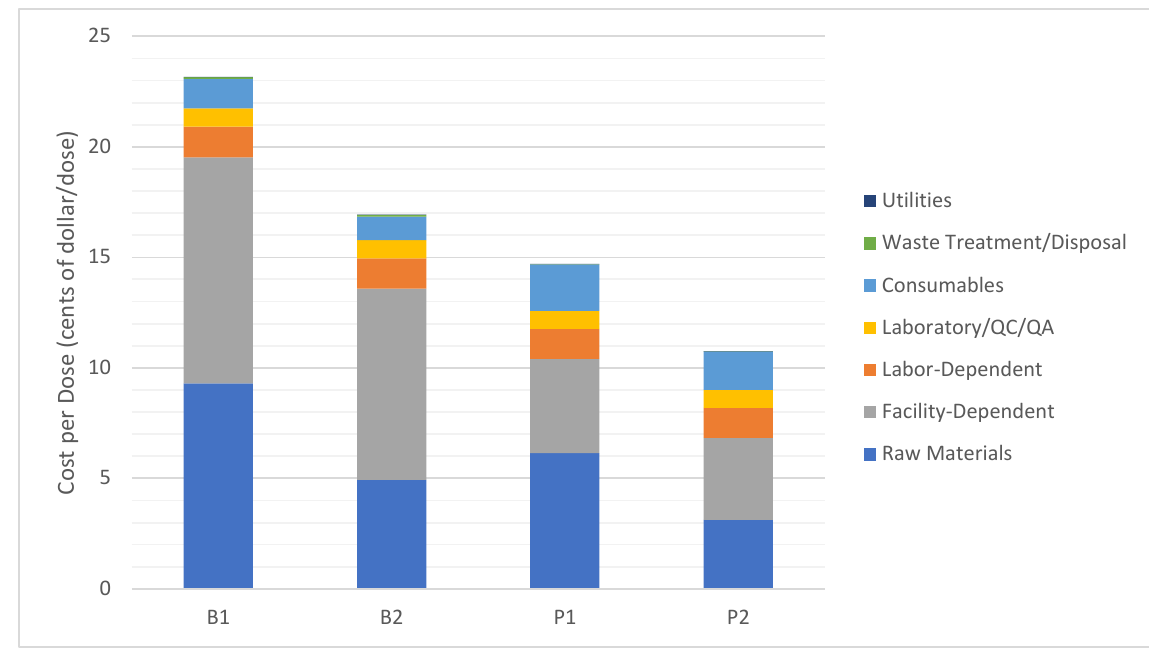
Figure 3. Total operating cost (given in terms of cost per dose) and its breakdown for each process scenario. One vaccine dose contains 5 × 10 10 VP with 10% overfill.